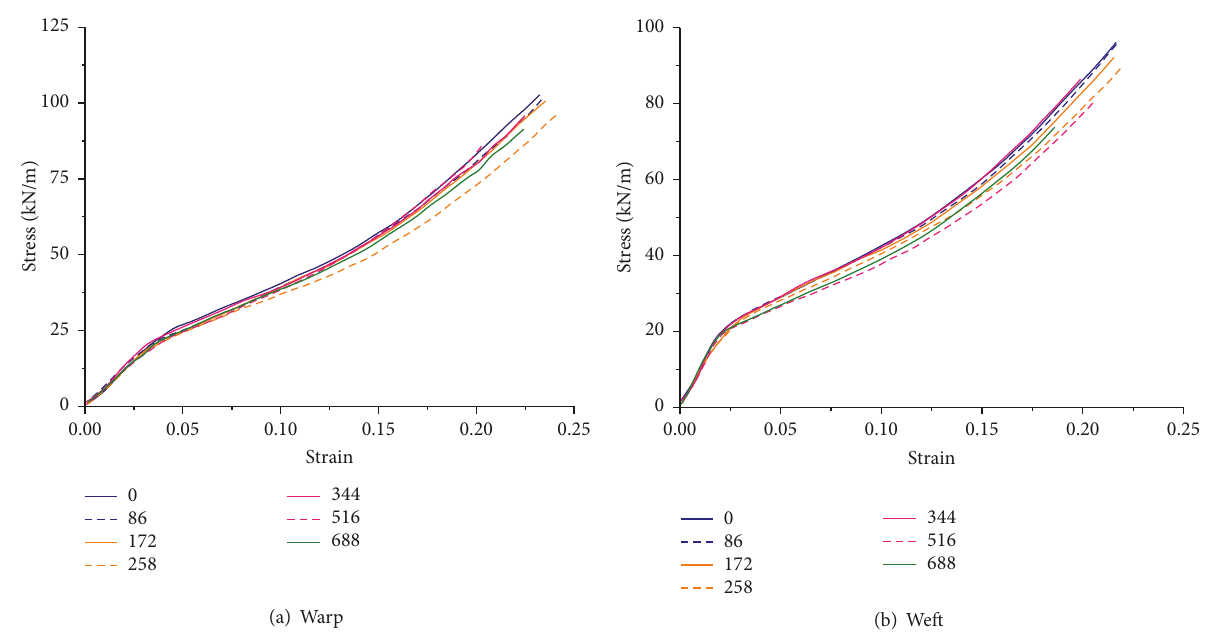
Figure 1: Stress-strain curves of Ferrari 1202 T2 under different aging